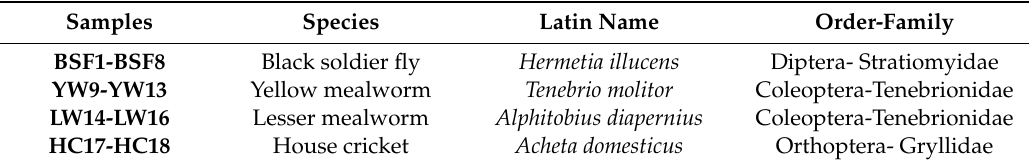
Table 1. Insect protein samples included in the study, with the Latin name , order and the family belongings. Samples Species Latin Name Order-Family BSF1-BSF8 Black soldier fly Hermetia illucens Diptera- Stratiomyidae YW9-YW13 Yellow mealworm Tenebrio molitor Coleoptera-Tenebrionidae LW14-LW16 Lesser mealworm Alphitobius diapernius Coleoptera-Tenebrionidae HC17-HC18 House cricket Acheta domesticus Orthoptera-